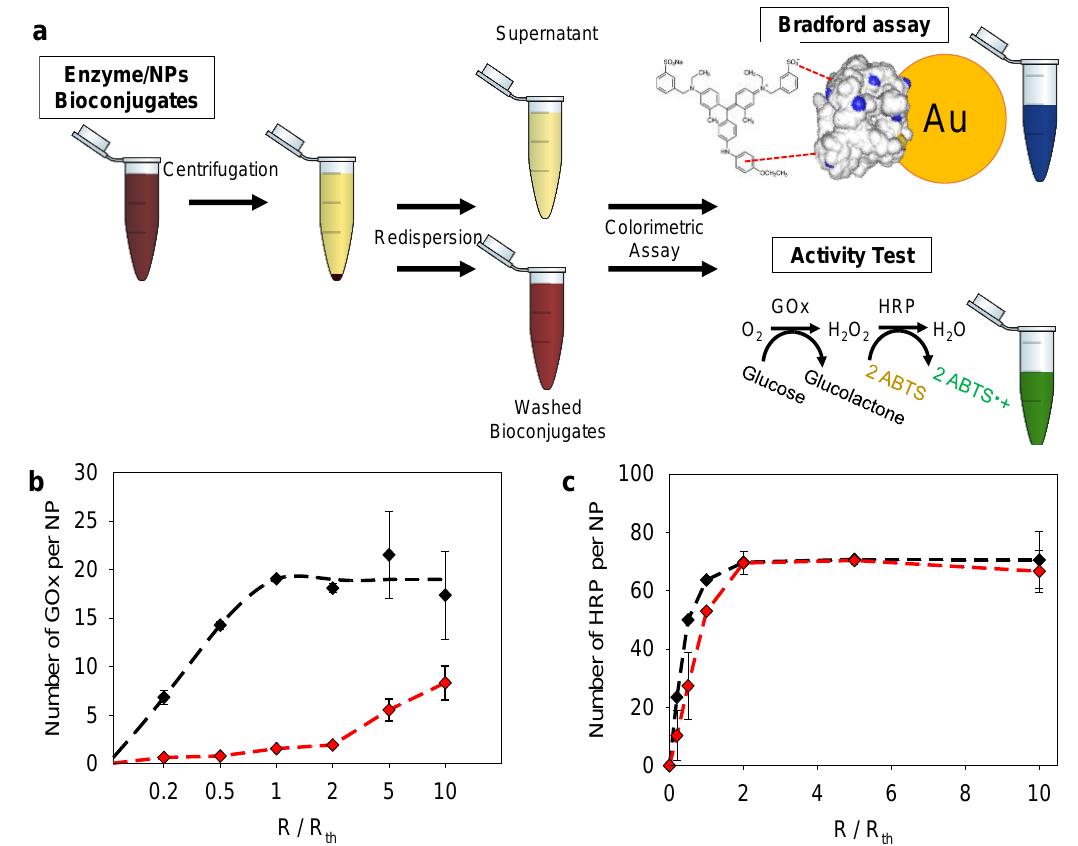
Figure 7. ( a ) Illustration of the Bradford and activity assays performed on enzyme/NP bioconjugates. Number of ( b ) GOx and ( c ) HRP per NP11 at different R / R th mixture ratios, determined by Bradford (black curve) and activity assay (red curve), taking as a reference the activity of the enzyme-free in solution.